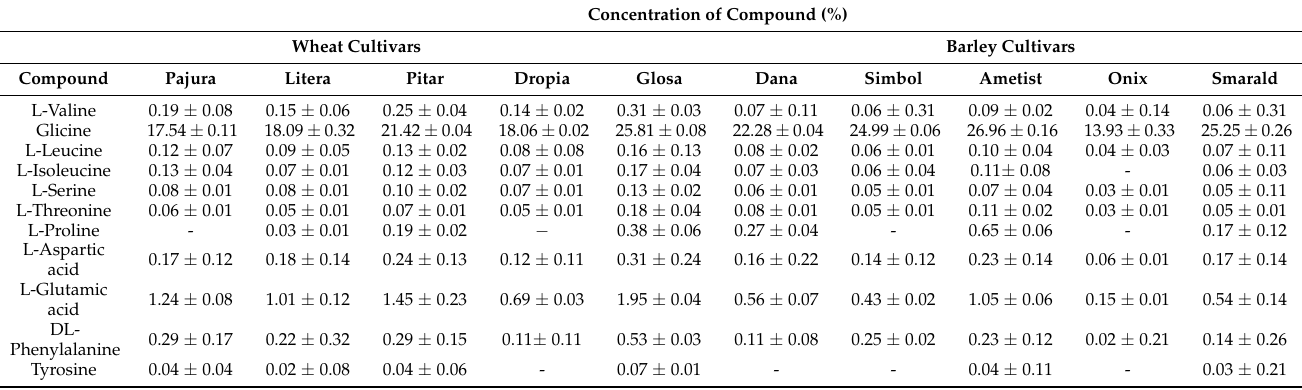
Table 8. Measured contents of the amino acid concentrations (means values ± standard